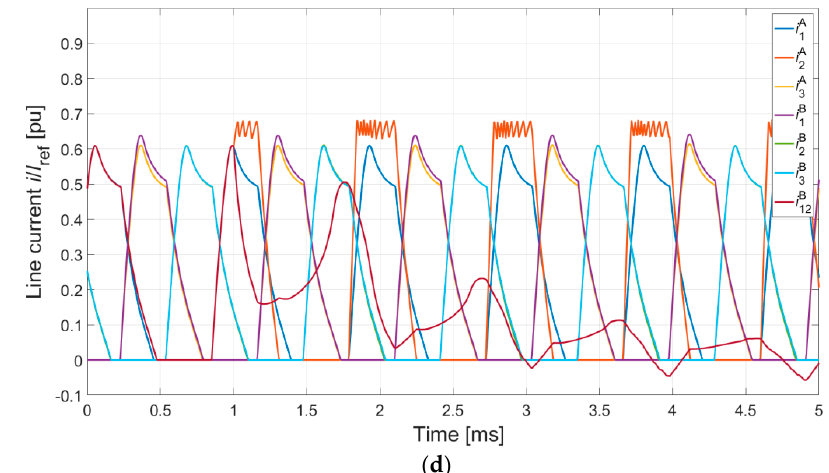
Figure 11. Relative electromagnetic torque and line currents in DCO mode for the DCBLDCM and the DCSRM at a shorted coil in channel B. ( a ) Electromagnetic torque T e for the DCBLDCM. ( b ) Line currents for the DCBLDCM. ( c ) Electromagnetic torque T e for the DCSRM. ( d ) Line currents for the DCSRM.